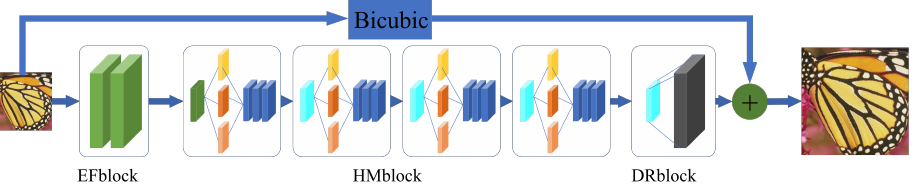
Figure 1. The overall structure of the proposed network. EFblock, HMblock and DRBlock are used for feature extraction, image enhancement, and image reconstruction, respectively.